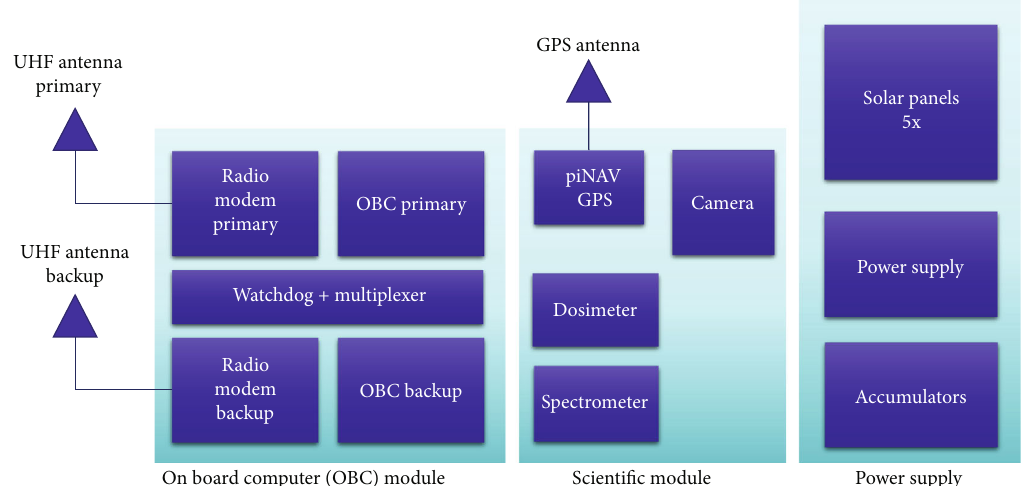
Figure 1: Simpli fi ed block diagram of Lucky-7. The satellite consists of the OBC, scienti fi c module, power supply system, communication, and navigation antennas.